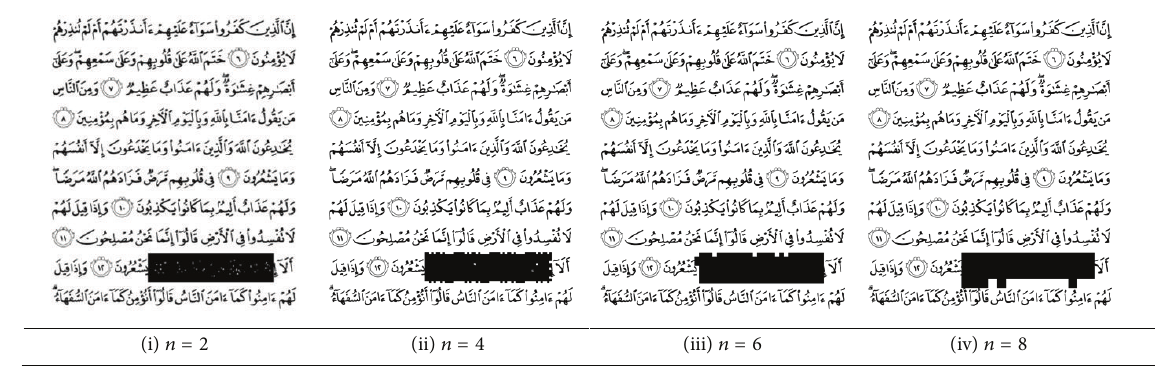
Figure 15: Tamper detection on collage attack